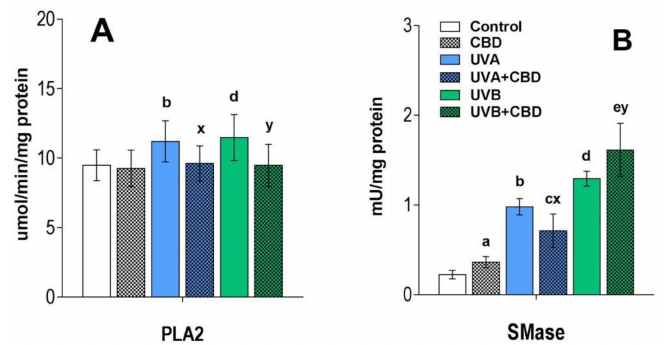
Figure 5. PLA2 activity panel ( A ) and neutral SMase activity panel ( B ) in keratinocytes isolated from the skin of control (Control) and UVA-irradiated rats (increasing doses from 0.5 to 5 J / cm 2 for 4 weeks) or UVB (increasing doses from 0.02 to 2 J / cm 2 for 4 weeks). These cells have not been treated (Control and UVA) or treated with CBD (CBD and UVA + CBD) (2.5 g CBD in 100 g petrolatum). The examined group of keratinocytes origin from two data sets each comprising four groups: (Control vs. CBD vs. UVA vs. UVA + CBD) and (Control vs. CBD vs. UVB vs. UVB + CBD). Values are mean ± SD, p < 0.05; (a), CBD vs. control; (b), UVA vs. control; (c), UVA + CBD vs. control; (d), UVB vs. control; (e), UVB + CBD vs. control; (x), UVA + CBD vs. UVA; (y), UVB + CBD vs. UVB.